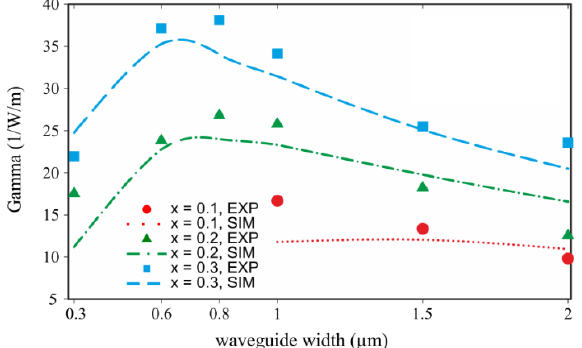
Figure 7. A comparison of experimental and numerical results of the nonlinear coefficient measurement as a function of the waveguide width for varying Ge concentration [55].